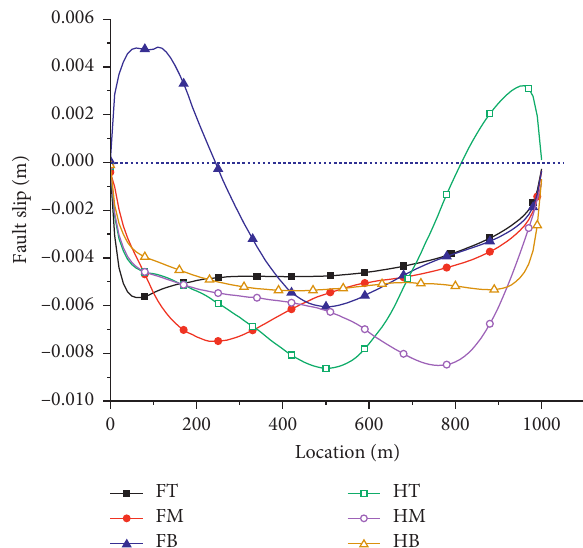
Figure 12: Fault slip along the fault plane when the fracturing region was FT, TB, FM, HT, HM, or